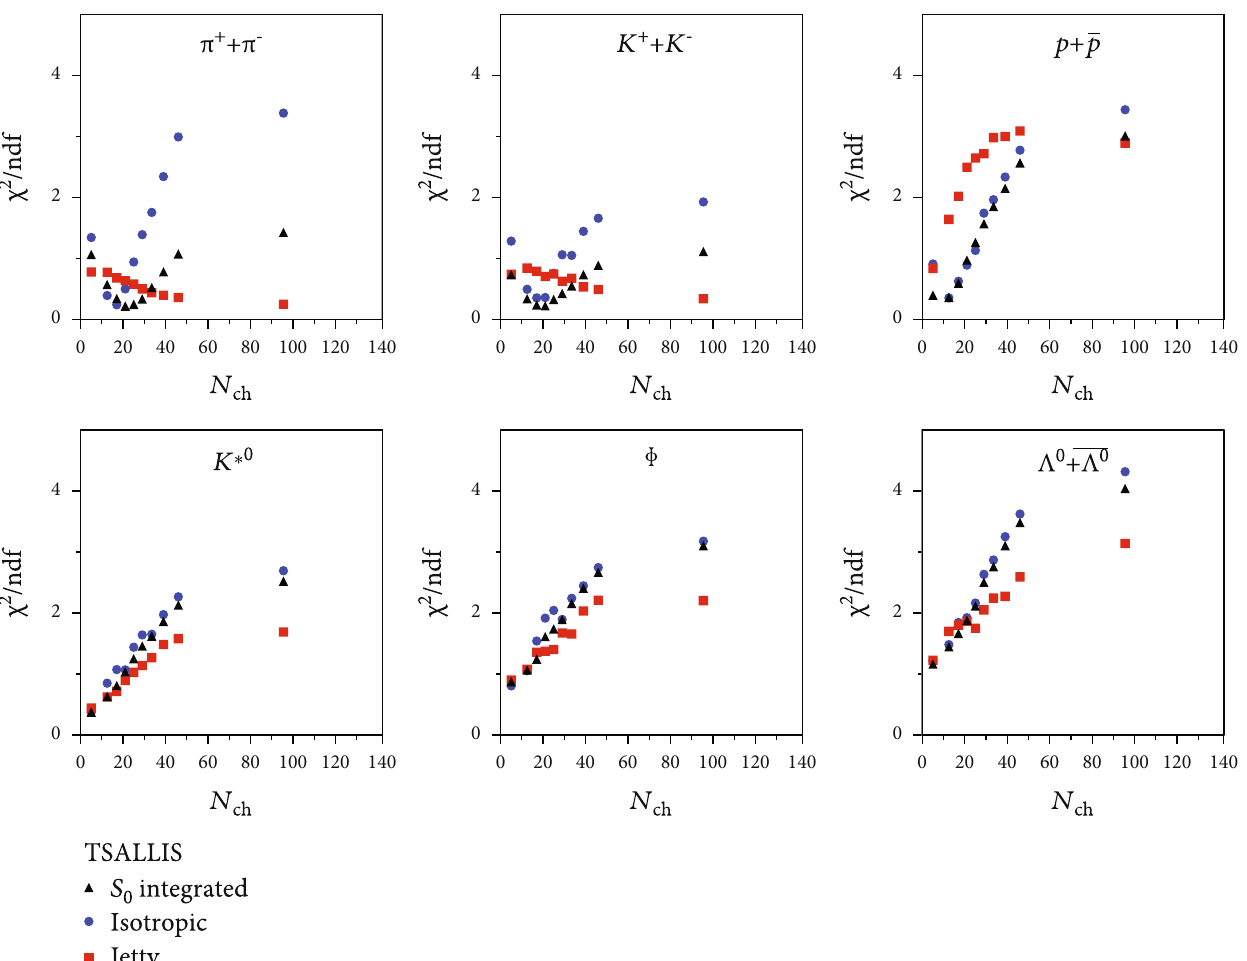
-spectra of identi fi ed hadrons using Tsallis distribution in di ff erent spherocity T